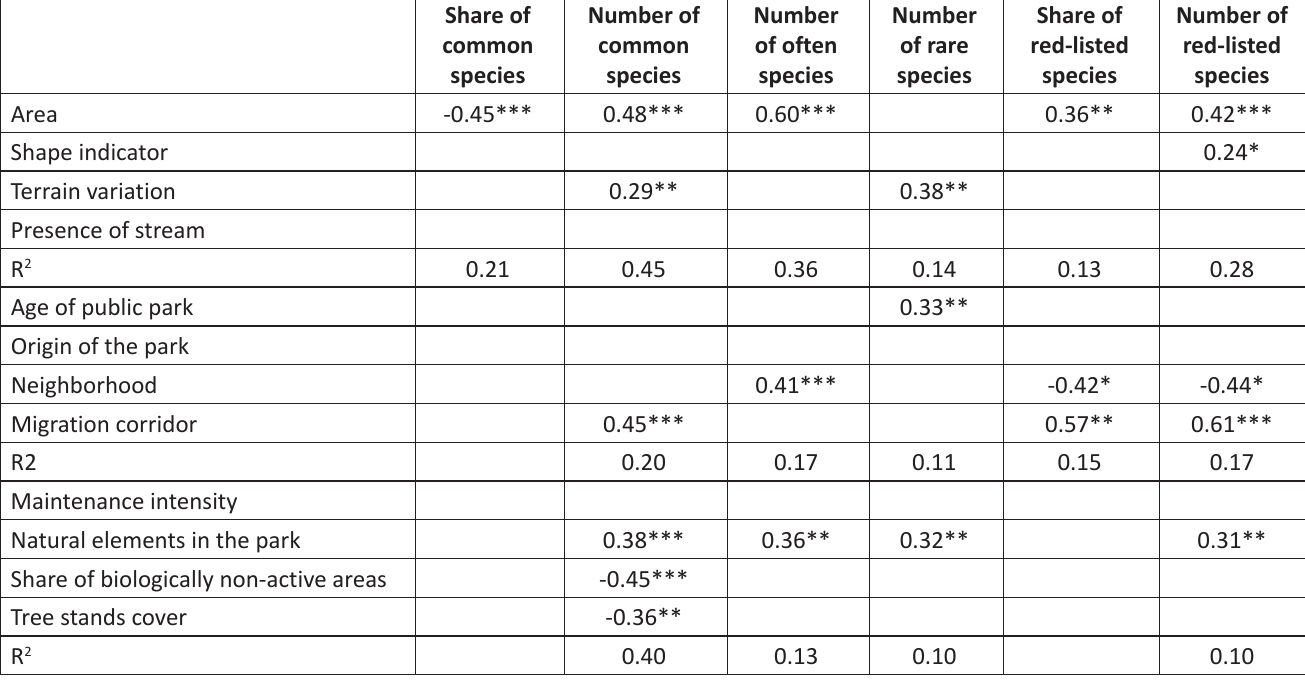
Table 5.Regression coefficients for the number of species of groups with different frequency of occurrence in the Flora of Poland depending on selected park parameters in